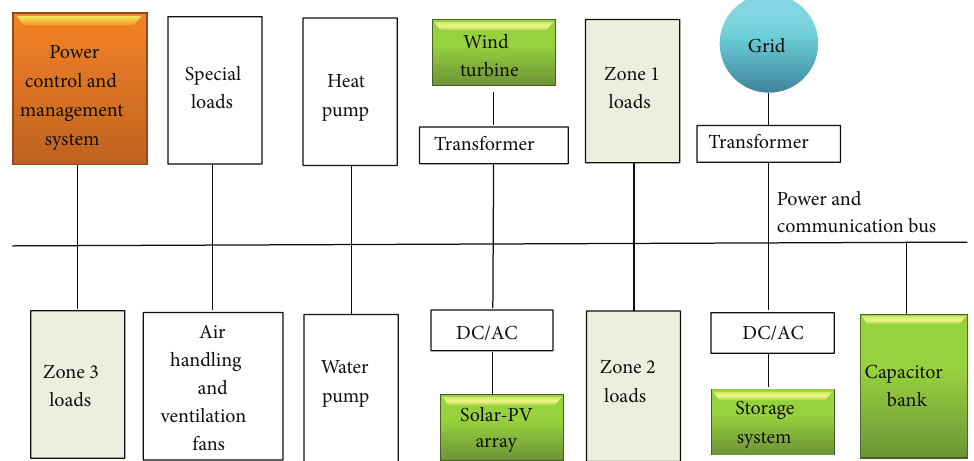
Figure 4: Schematic of the proposed building CCHP MG.